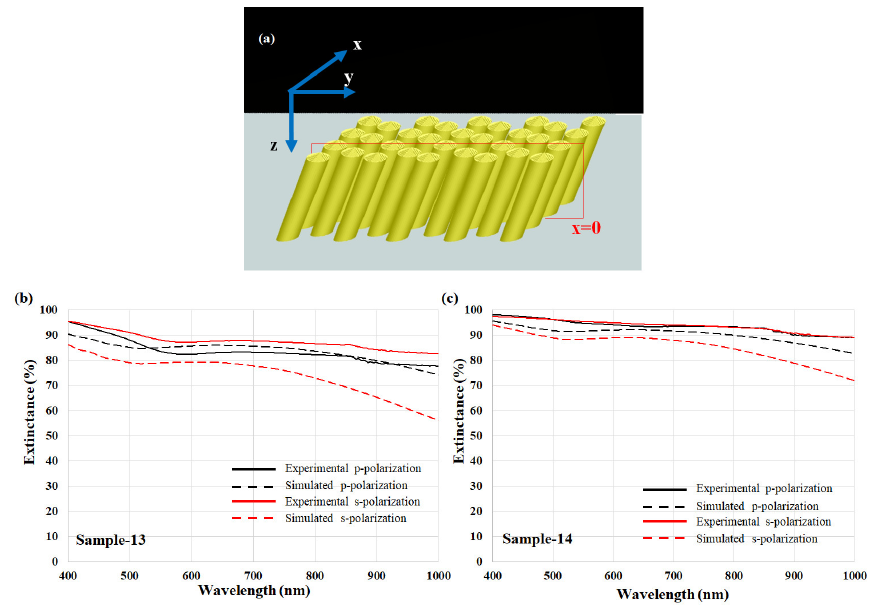
Figure 10. ( a ) Schematic TiN NRA used in the simulation. Simulated extinctance and measured extinctance of ( b ) Sample-13 and ( c ) Sample-14 for s- and p-polarization.